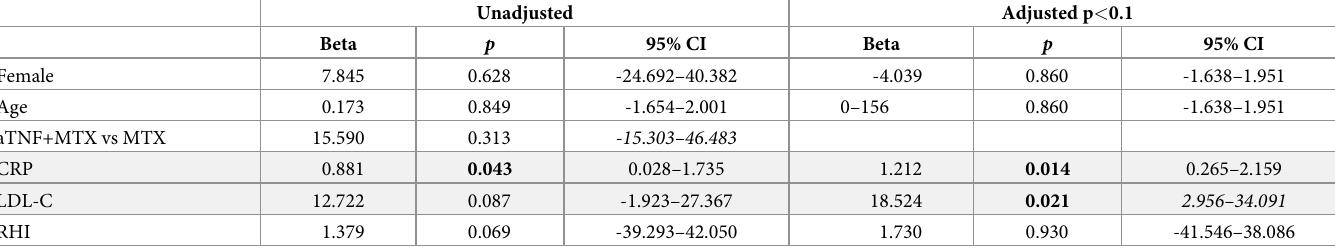
Table 3. Predictors of baseline